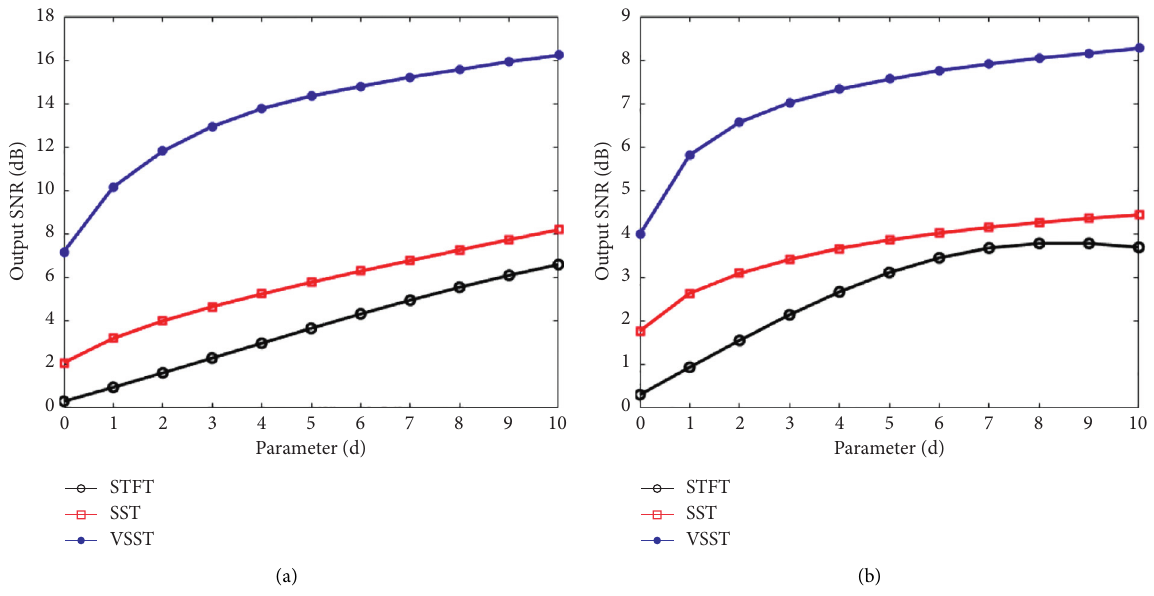
Figure 6: Quality of reconstruction as a function of (d): (a) noise-free and (b) with